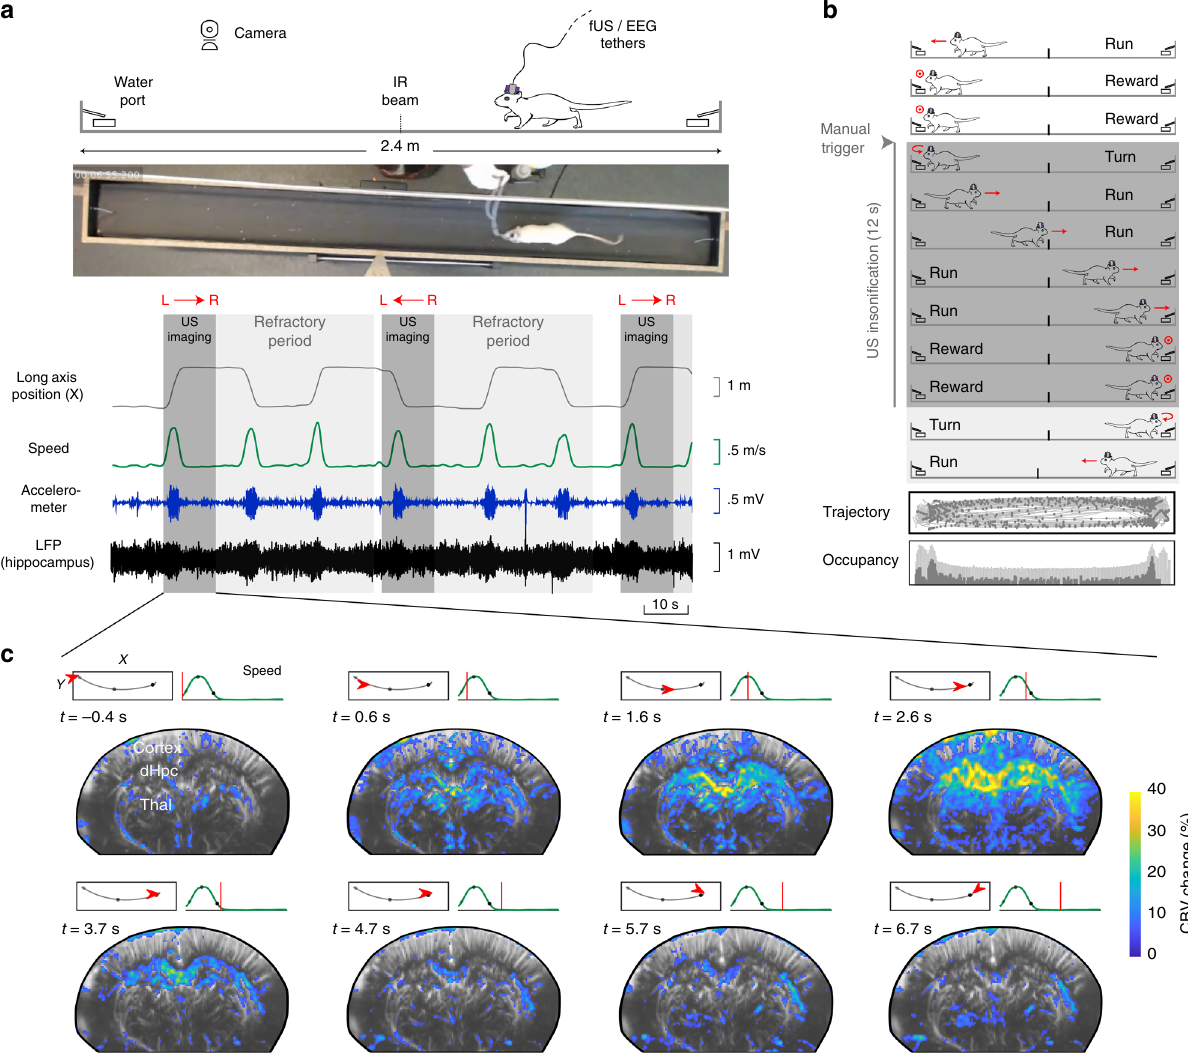
Fig. 1 Simultaneous functional ultrasound/LFP/video recordings reveal single-run hemodynamics in deep brain structures. a Schematic and picture of the fUS – LFP – video setup. Rats are trained daily to run back and forth on a 2.4 m linear track for water reward, given at both ends. Video, electrophysiology, and accelerometer data are acquired continuously. Ultrasound data is acquired in bouts lasting 12 s (shaded dark gray), interleaved with a 40-s refractory period (shaded light gray), during which ultrasound data is beamformed. Animal position on the track (gray) and speed (dark green) are extracted of fl ine concurrently with LFP processing. b Details of single-run imaging. Ultrasound acquisition is triggered manually by the experimenter, when the animal initiates its turn. A typical 12-s imaging sequence is composed of Turn (1 s) – Run (3 – 4 s) – Reward (7 – 8 s). A typical recording session lasts 30 – 40 min and contains 80 – 100 trials, a third of which are imaged (2/3 occurring during the refractory period). Trajectory and occupancy of the track are displayed at the bottom for the full session (light gray) and for the imaged runs (dark gray: one Doppler frame, 200 ms compounding). c Spatiotemporal dynamics of the vascular network during a single run. A typical coronal plane (Bregma − 4.0 mm) reveals cerebral blood volume (CBV) in cortical, hippocampal, and thalamic regions. For each 12-s US insoni fi cation, we formed 60 Power Doppler frames (8 frames showed, 5 Hz total sampling) based on ultrasound echoes. This reveals prominent activation in the dorsal hippocampus (30 – 40 % CBV change), peaking 2.0 – 2.5 s after fUS onset, that is 1.5 – 2.0 s after run onset. Timing from run onset is given for each frame. Top left: Animal position on the track (red arrow) overlaid on trajectory (gray line) Top right: Animal speed as a function of time (red line: current position). Gray dots mark run onset (light gray), run peak (gray), and run end (dark